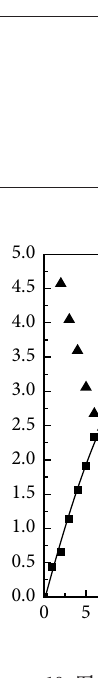
Figure 10: The absorbed capacity of AC1 for methylene blue with concentration of 12.016mg L −1 at 25 ∘ C and pH = 7.0 as a function of time ( ◼ represents experiment data; the full line represents fit of experimental data with a pseudo-first-order kinetic equation; 󳵳 represents concentration of methylene blue in